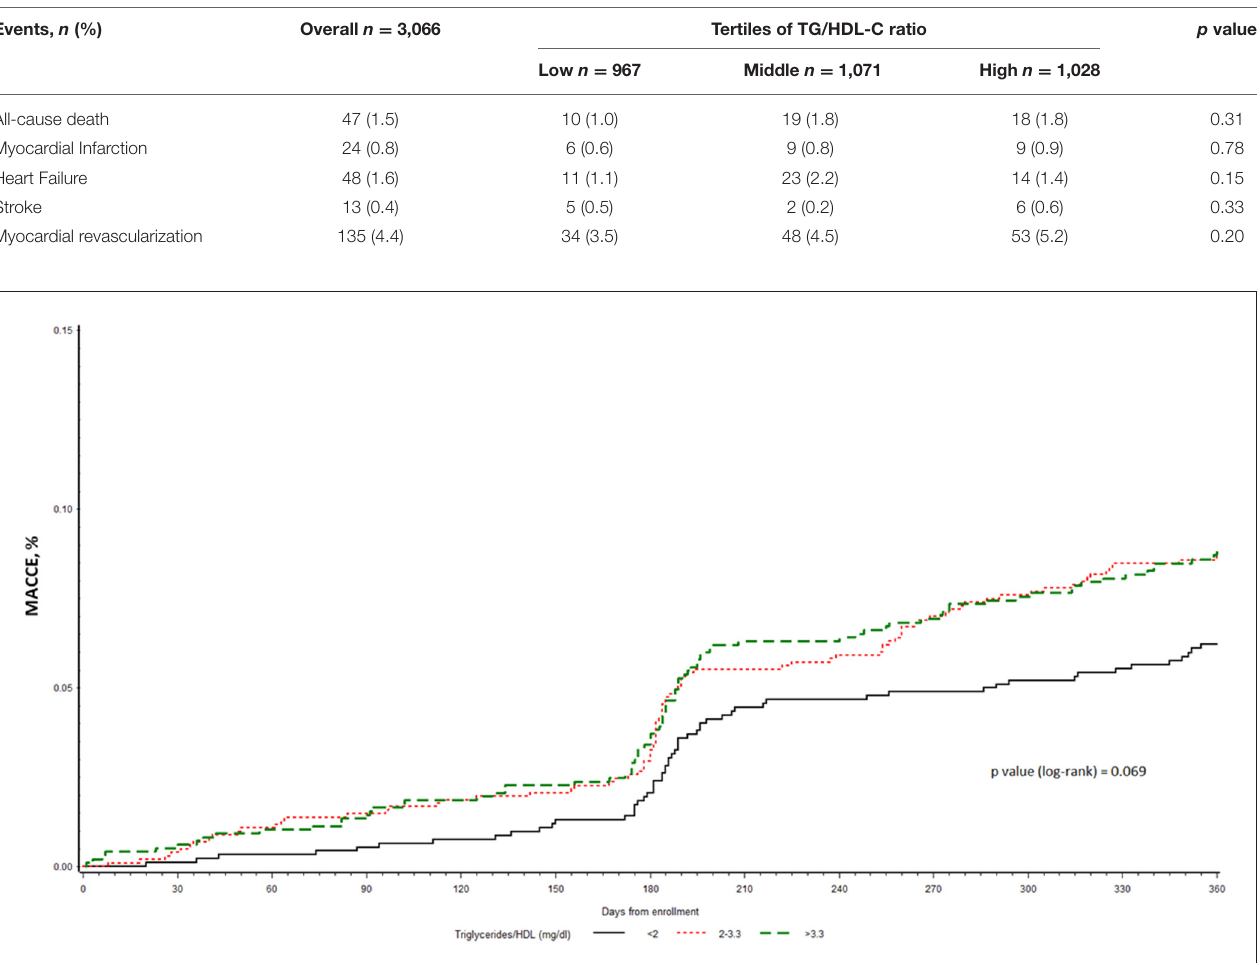
FIGURE 3 | Kaplan-Meier curves for time to MACCE among the three subgroups of CCS patients at VHR stratified by TG/HDL-C